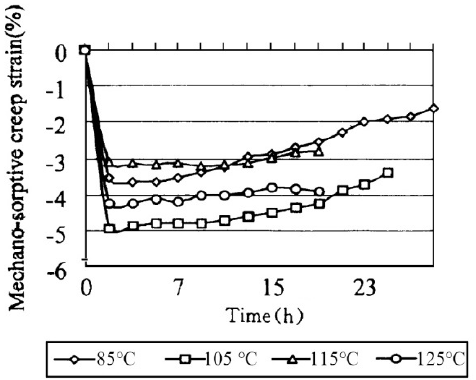
Figure 4. Mechano-sorptive creep strain changes with drying time [79].